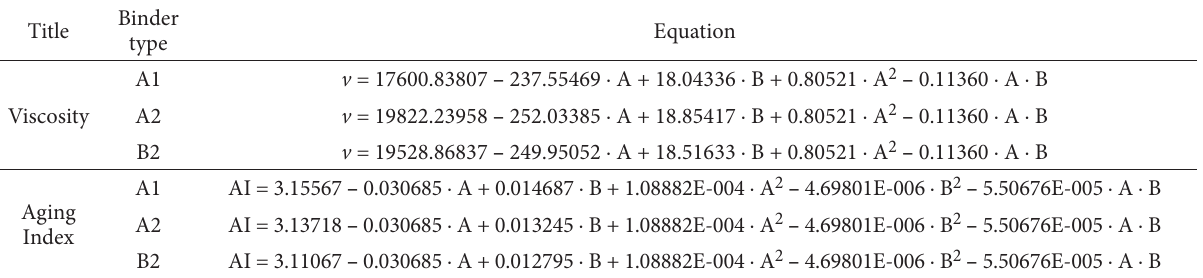
Table 5. Equations obtained from response surface